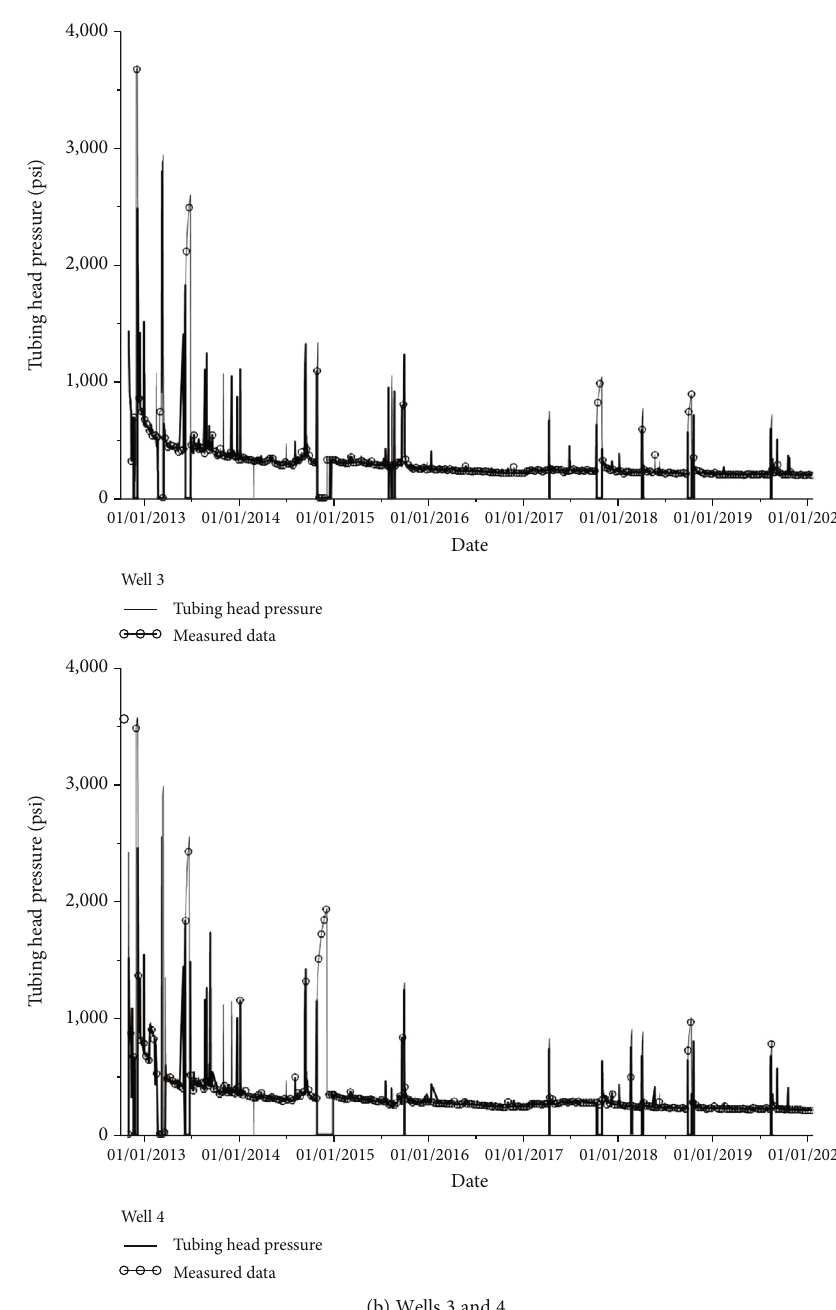
Figure 16: History matched results of tubing head pressures for wells 1 to